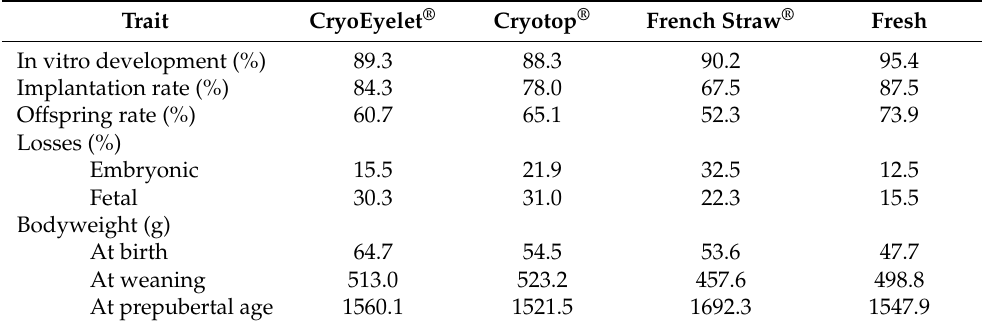
Table 1. Summary of the traits and means from each experimental group analyzed. Trait CryoEyelet ® Cryotop ® French Straw ® In vitro development (%) 89.3 Implantation rate (%) Offspring rate